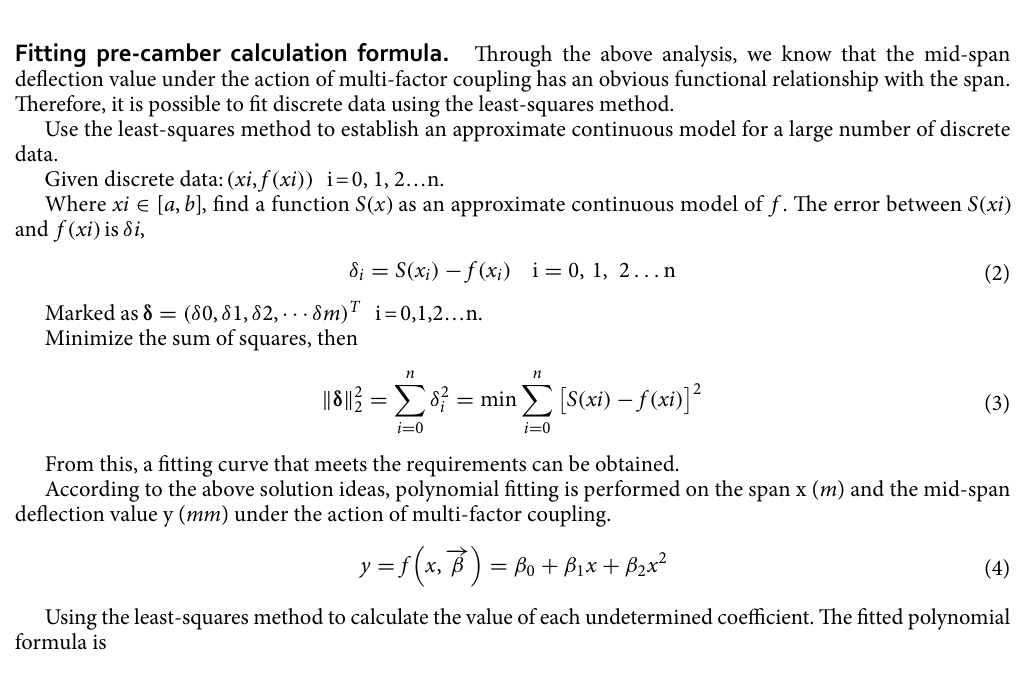
Figure 6. Fitting polynomial curve of the bridge